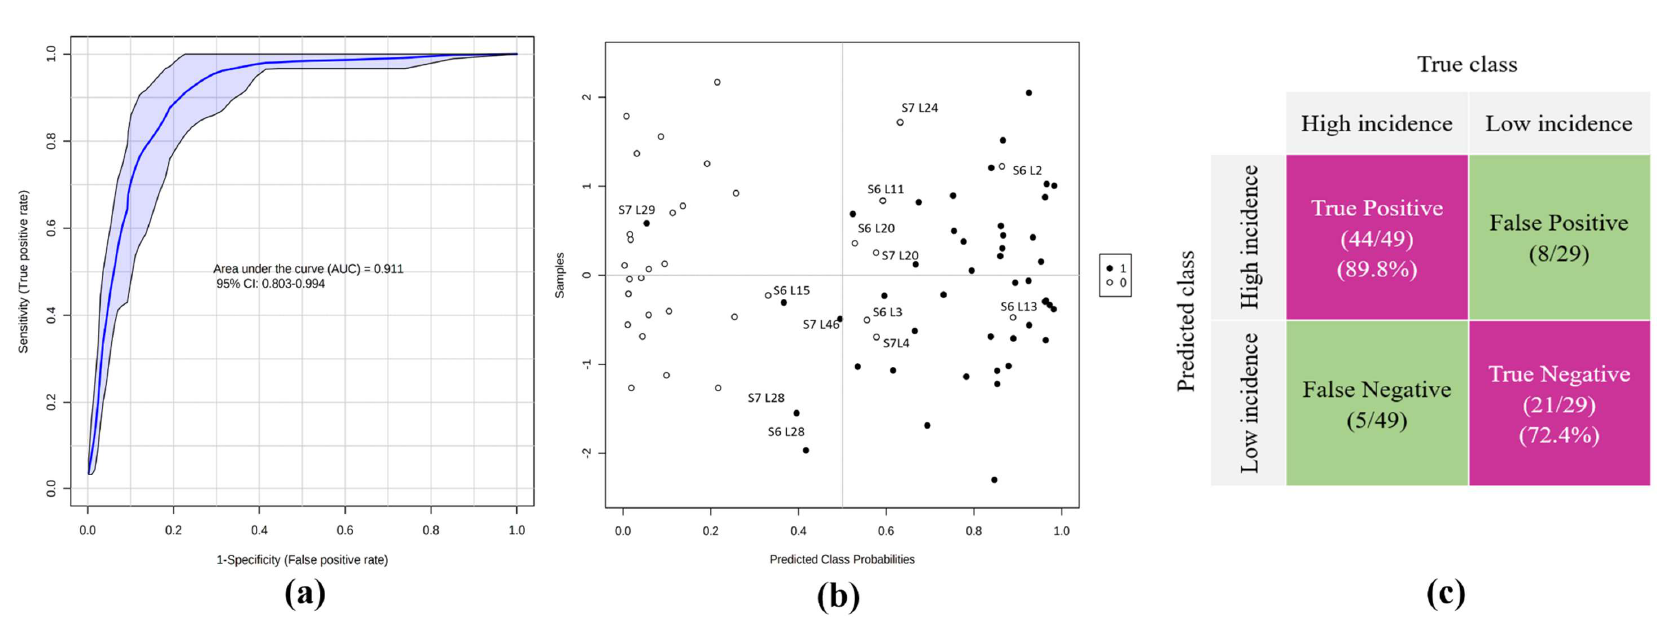
Figure 6. Classification of bananas lots according to the incidence of banana wilt (BW). ( a ) Receiver operating characteristic (ROC) curve after obtained by Random Forest as classification method. The values generated for the area under the curve (AUC) (0.91) along with the 95% confidence intervals (CI) (0.80–0.99) are given within the graph and accuracy: 84.10%; ( b ) Predicted class probabilities for each banana lot, allowing display of misclassified bananas lots (lots of high BW incidence are shown as black dots; lots of low BW are shown as white dots). Since a balanced subsampling approach is used for model training, the classification limit is always in the center (x = 0.5, the dotted line); ( c ) Confusion matrix showing the number of true positives (44/49), true negatives (21/29), false positives (8/29) and false negatives (5/49). Sensitivity and specificity are given in the regions highlighted in purple, being 89.80% and 72.40%, respectively.